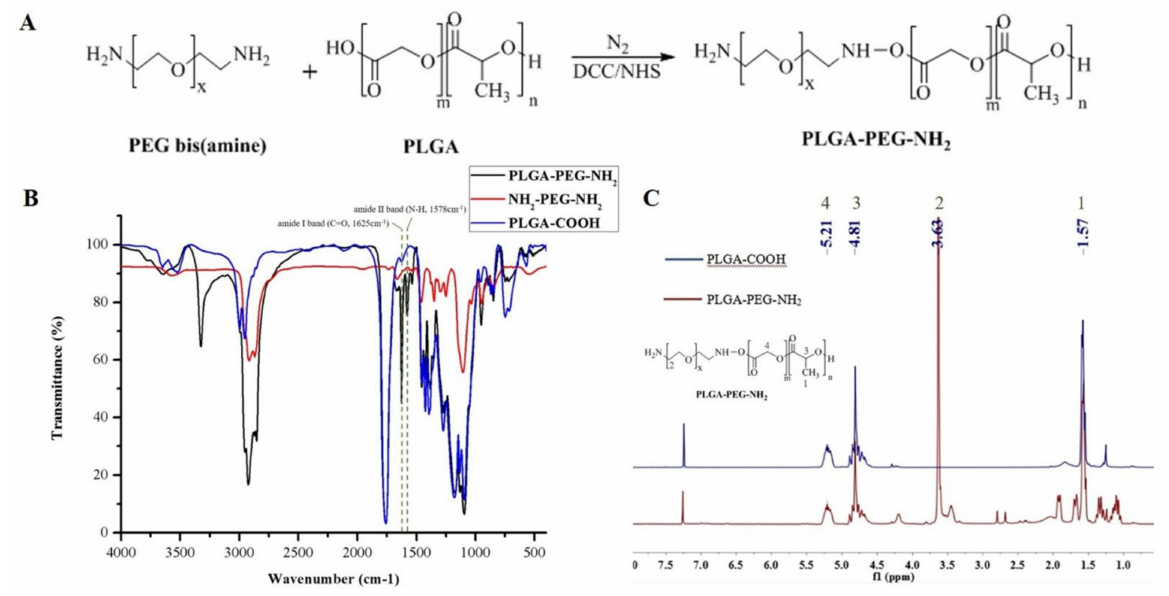
Figure 1. Characterizations of synthesized copolymers by 1 H NMR and FTIR spectroscopies. ( A ) Synthesis scheme; ( B ) FTIR spectra of PLGA-COOH, NH 2 -PEG-NH 2 and PLGA-PEG-NH 2 ; ( C ) 1 H NMR spectra of PLGA-COOH and PLGA-PEG-NH 2